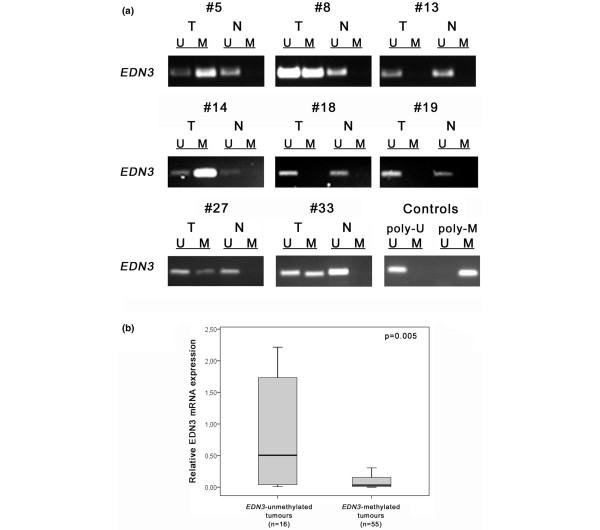
EDN3 promoter methylation in primary breast cancer. (a) Methylation-specific polymerase chain reaction (MSP) was performed on bisulphite-treated DNA from breast carcinomas (T) and matching normal breast tissue (N). Representative MSP results from eight patients are shown. MSP controls were commercially available poly-unmethylated (poly-U) or in vitro poly-methylated (poly-M) DNA. (b) Box plot demonstrating the significant association between EDN3 promoter methylation and EDN3 mRNA expression in these tissues. For 71 samples, EDN3 expression has been assessed in parallel to EDN3 promoter methylation. EDN3-methylated tumours show significant downregulation as compared with EDN3-unmethylated tumours (P = 0.005, Mann-Whitney U test). Horizontal lines indicate group medians, and boxes indicate 25% to 75% quartiles, range, peak and minimum. EDN3, endothelin-3; M, methylated; U, unmethylated.